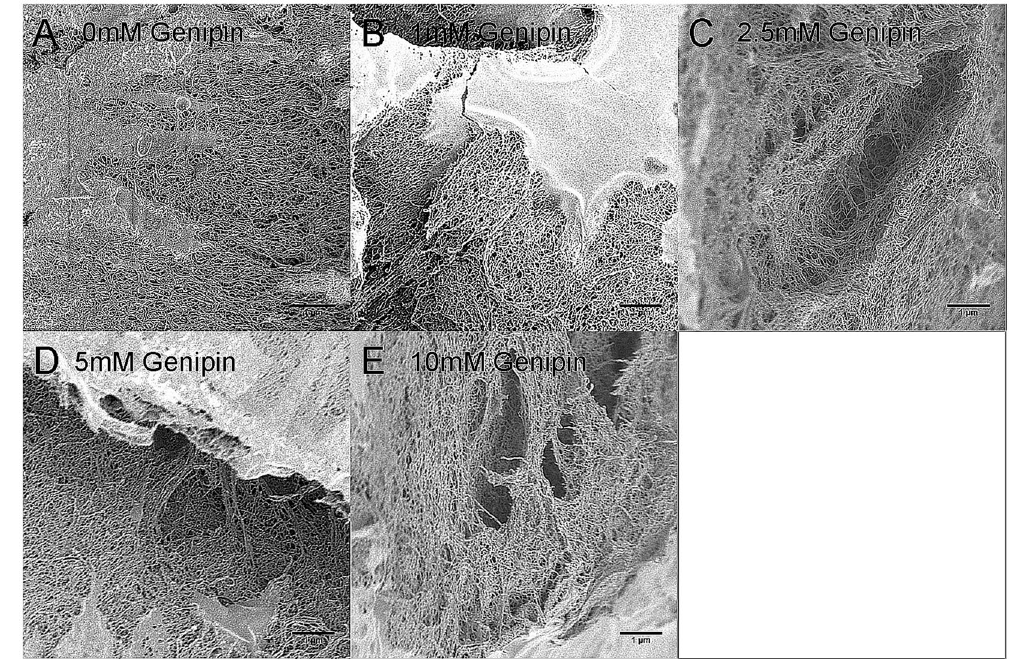
Figure 4. Scanning electron microscopy images of fibrin scaffolds crosslinked with the following concentrations of genipin: ( A ) 0 mM ( B ) 1 mM ( C ) 2.5 mM ( D ) 5 mM and ( E ) 10 mM. Images are representative of 3 samples taken (biological n = 3, technical n = 3).